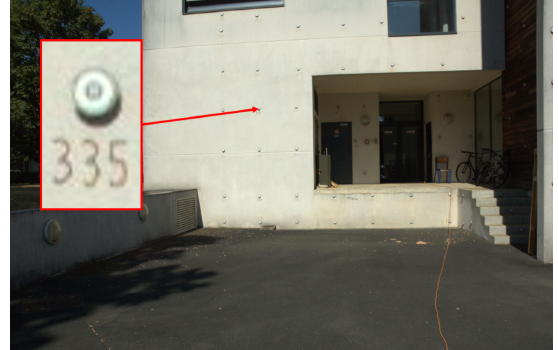
Figure 7. Image canvas for adjustment phase